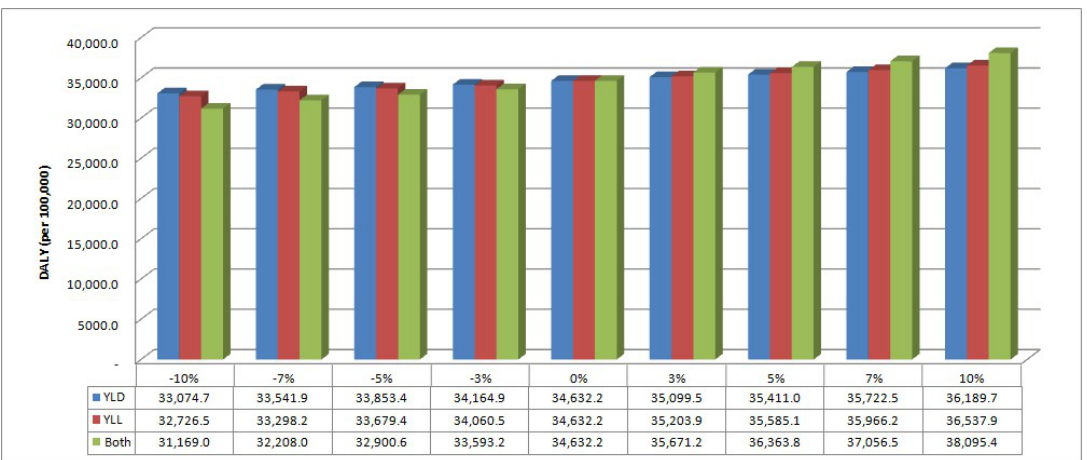
Figure 1. The results of sensitivity analysis. DALY: disability-adjusted life-years; YLD: years lost due to disability; YLL: years of life lost.